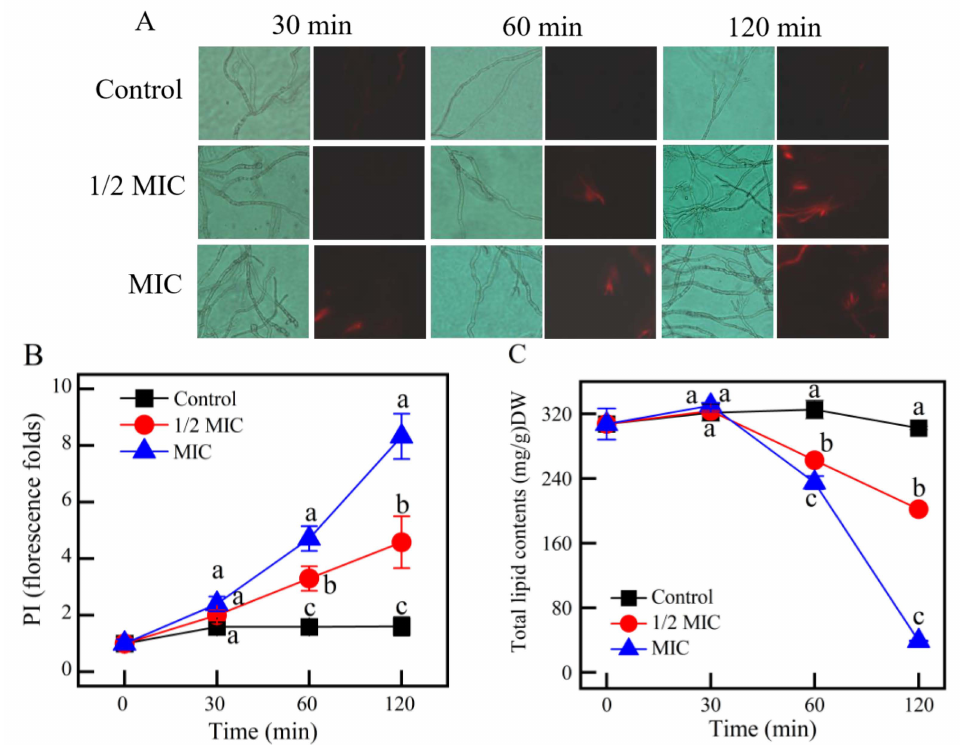
Figure 7. Effect of γ -CDCL on plasma membrane permeability of P. digitatum mycelia. ( A ) Fluores- cence images of different treatment concentrations (Control; 1/2 × MIC; 1 × MIC) with γ -CDCL for 30, 60, 120 min; ( B ) The fluorescence folds change of PI staining. ( C ) Effect of γ -CDCL on the total lipid contents of P. digitatum mycelia. Data are expressed as the means ± standard deviation of pooled data ( n = 3, p < 0.05). γ -CDCL, cinnamaldehyde/ γ -cyclodextrin inclusion complex; MIC, min- imum inhibitory concentration. Dissimilar lowercase letters in the histogram express the statistical significance among different treatments at the same